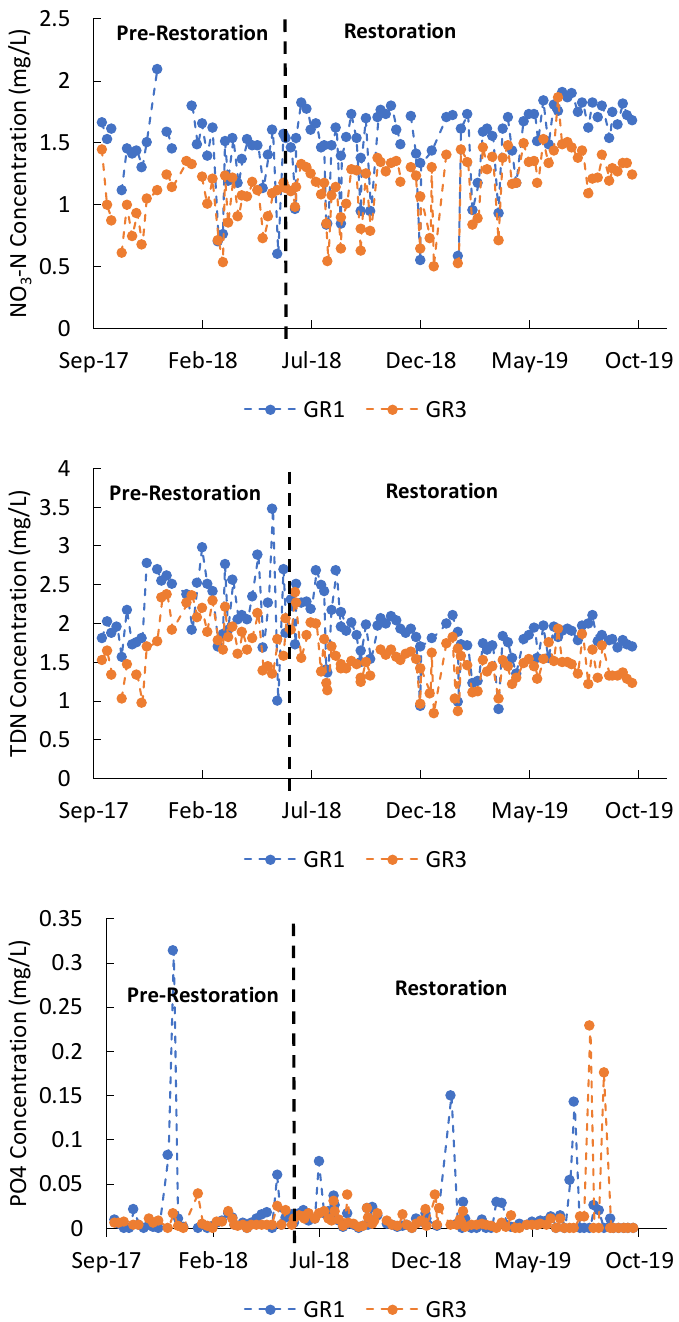
Figure 8. Stream water concentrations at the upstream (GR1) and downstream (GR3) monitoring sites for nitrate-N (NO 3 -N), total dissolved N (TDN), and ortho-P (PO4). The dashed vertical line represents when in-stream construction began on 15 June 2018.